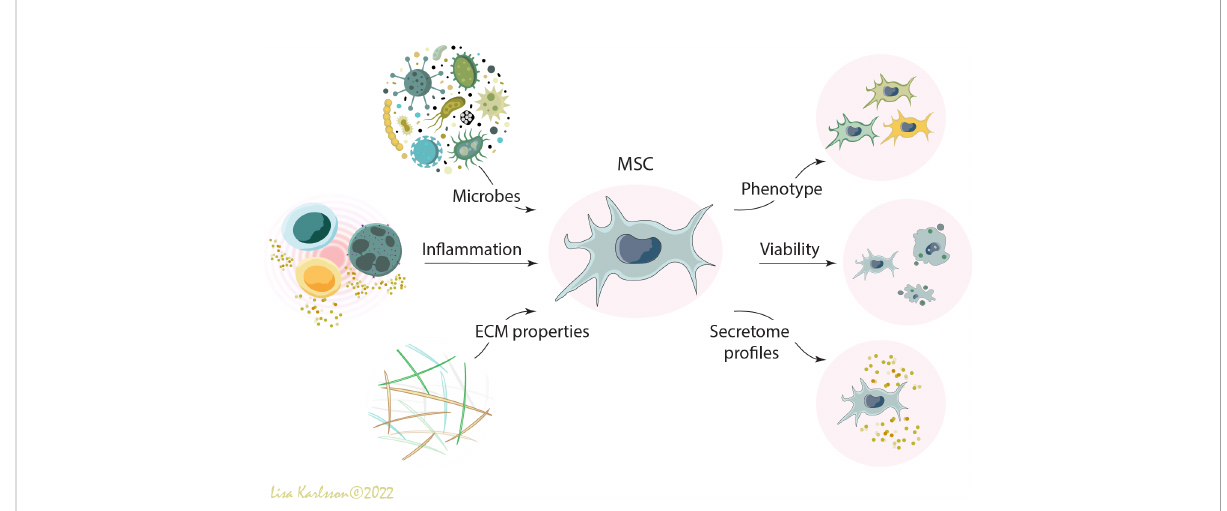
FIGURE 1 A schematic illustration describing how different environmental factors such as microbes ( e.g. bacteria, virus, fungi, and PAMPs), in fl ammation ( e.g. in fl ammatory cells and pro- and anti-in fl ammatory cytokines), and extracellular matrix properties ( e.g. DAMPS, emphysema, fi brosis, elastic tendency of the lung, and oxygen tension) in fl uence the viability, phenotype, and functions of administered human mesenchymal stromal cells (MSCs). MSC, mesenchymal stromal cells; PAMPS; pathogen-associated molecular patterns; DAMPS, danger-associated molecular patterns; ECM, extracellular matrix. Illustration created by Lisa